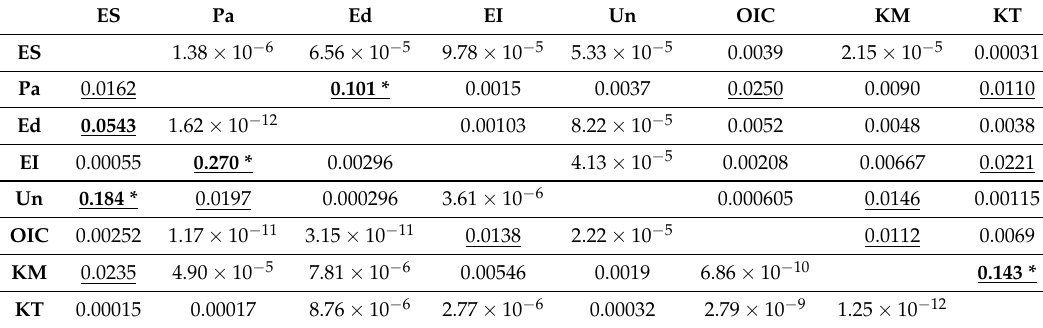
Table 4. p -values of the chi-squared difference tests for latent variable correlations. The upper triangle has as null hypothesis that the correlation is one. The lower triangle has as null hypothesis that the correlation is 0. Especially high values are marked: underlined referes to values higher than 0.01, boldfaced refers to values higher than 0.05, and * (asterisk) refers to values higher than